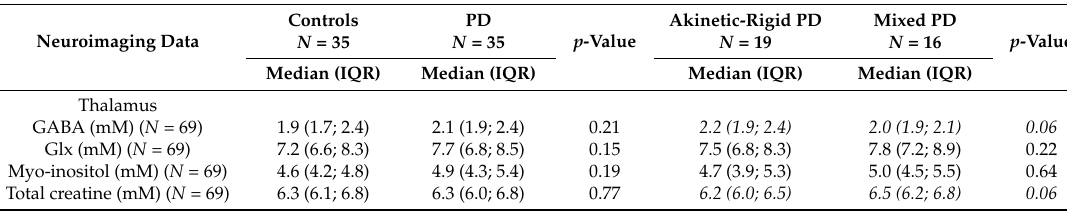
Table 3. Spearman correlation coefficients with 95% confidence interval between age, neuroimaging data, and motor variables in 35 Parkinson patients.